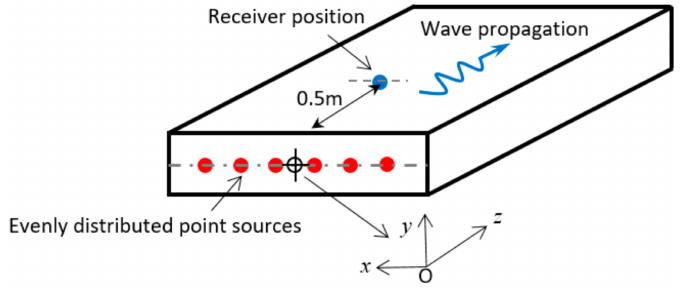
Figure 4. Point source arrangement to excite a wave mode in the rectangular